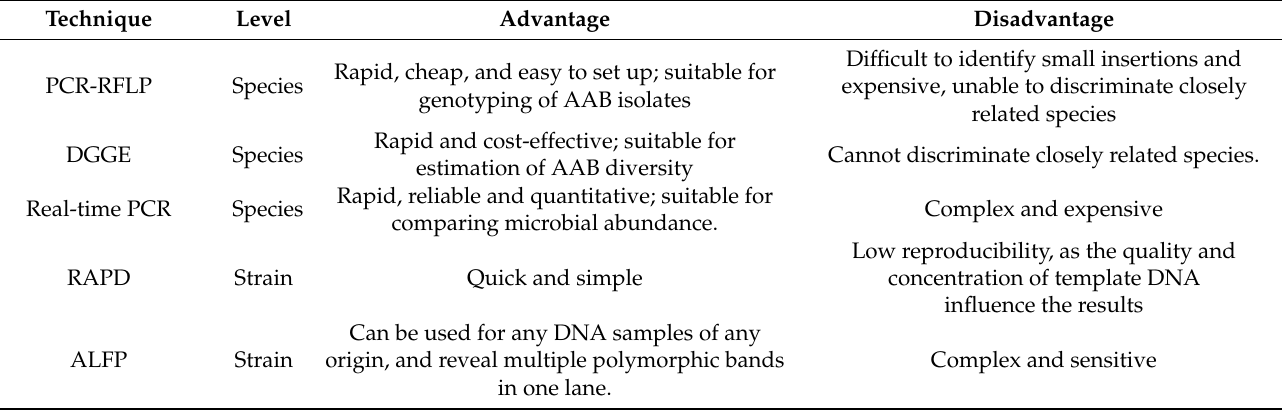
Table 9. Commonly used molecular techniques applied in AAB identification and